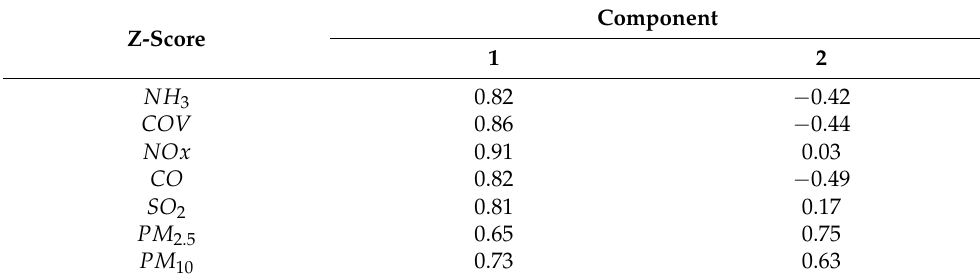
Table 5. Component